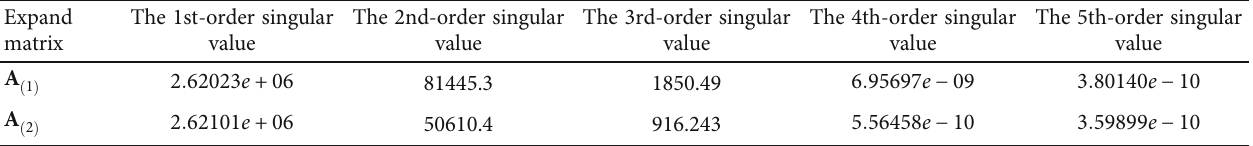
Table 2: HOSVD decomposition results of the LPV model.